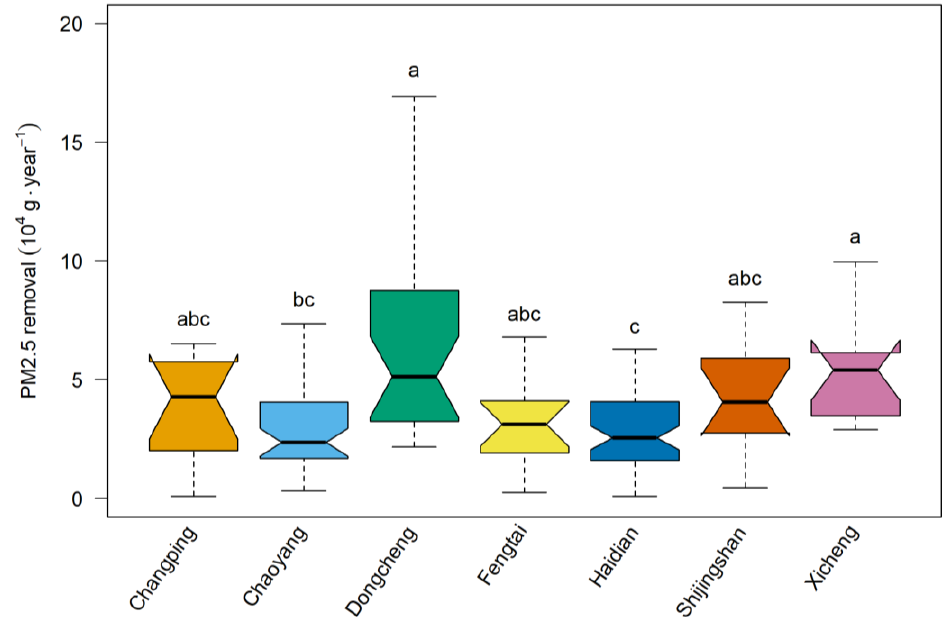
Figure 3. PM 2.5 retention of the sample plots in the 7 districts: a, b, c: Different letters indicate significant differences at a 0.05 level (2-tailed).